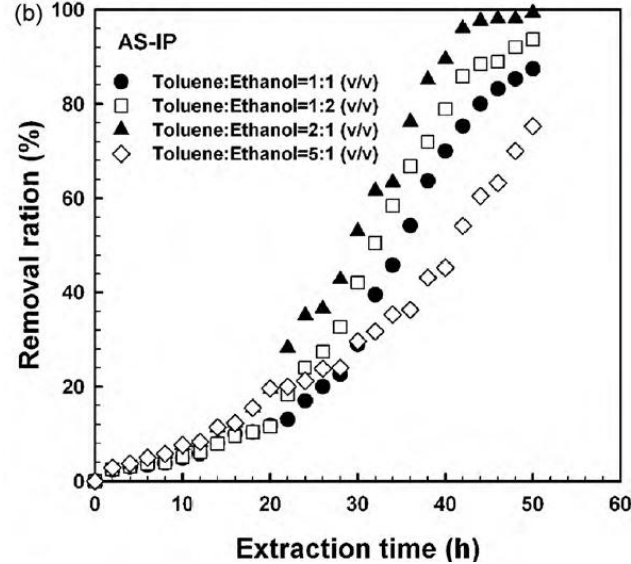
Figure 5. Removal ratio of aspirin from MIP particles (212 µm) as a function of the time of incubation with different toluene:ethanol mixtures. Reprinted from Byun et al. [39] with permission from Elsevier.